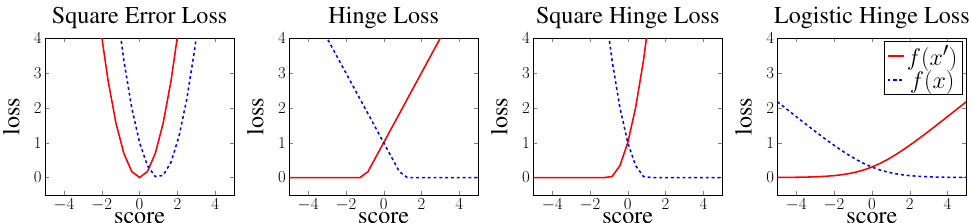
Figure 2. Plot of the loss growth of di ff erent types of pointwise knowledge graph embedding loss